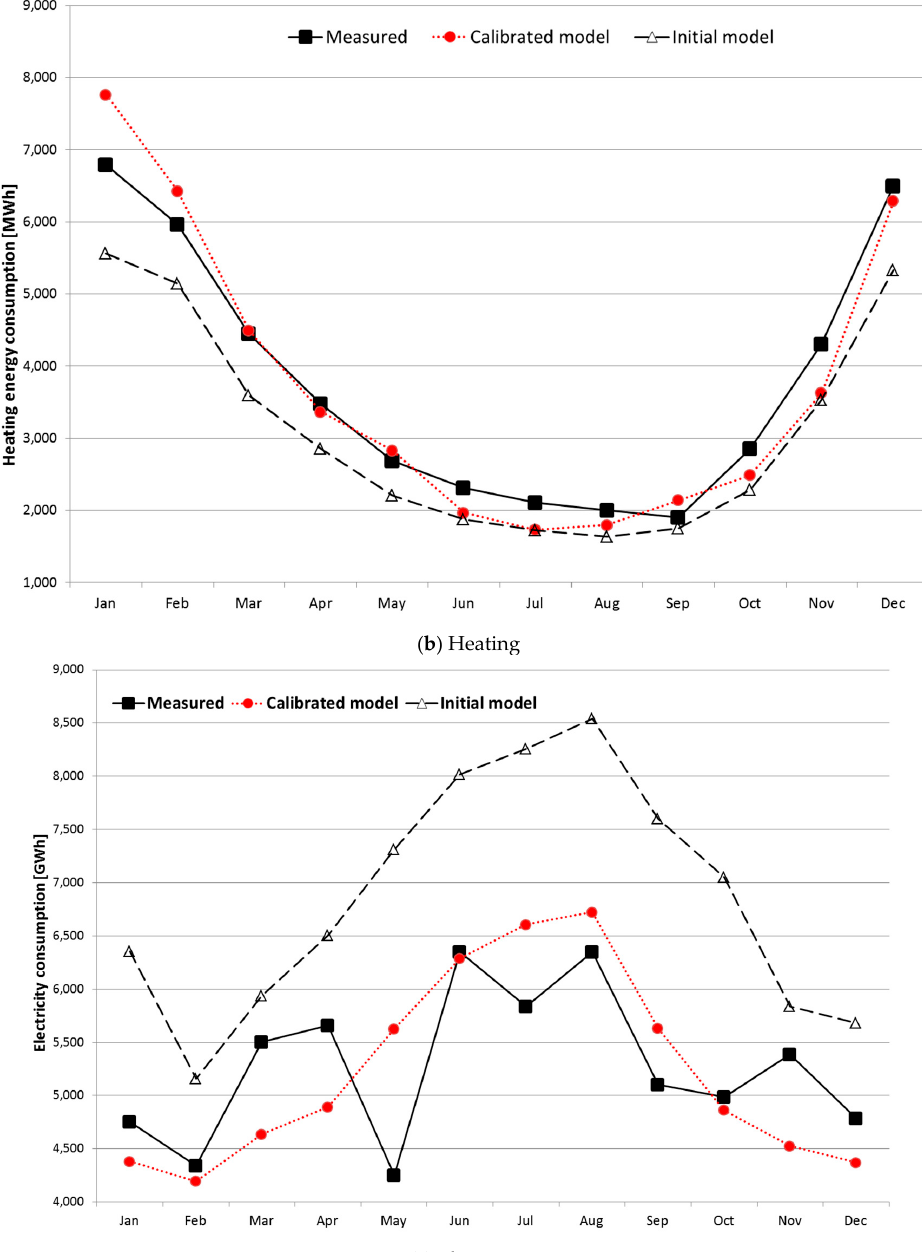
Figure 4. Comparison of the monthly energy usage profiles of the calibrated model with actual energy measurement.